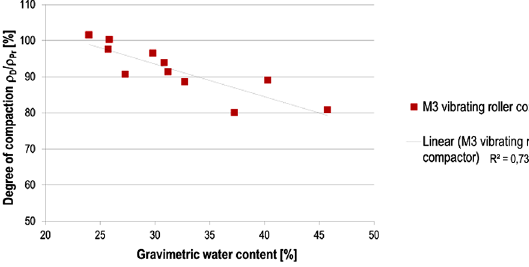
Fig. 11. DOC for M3 with roller